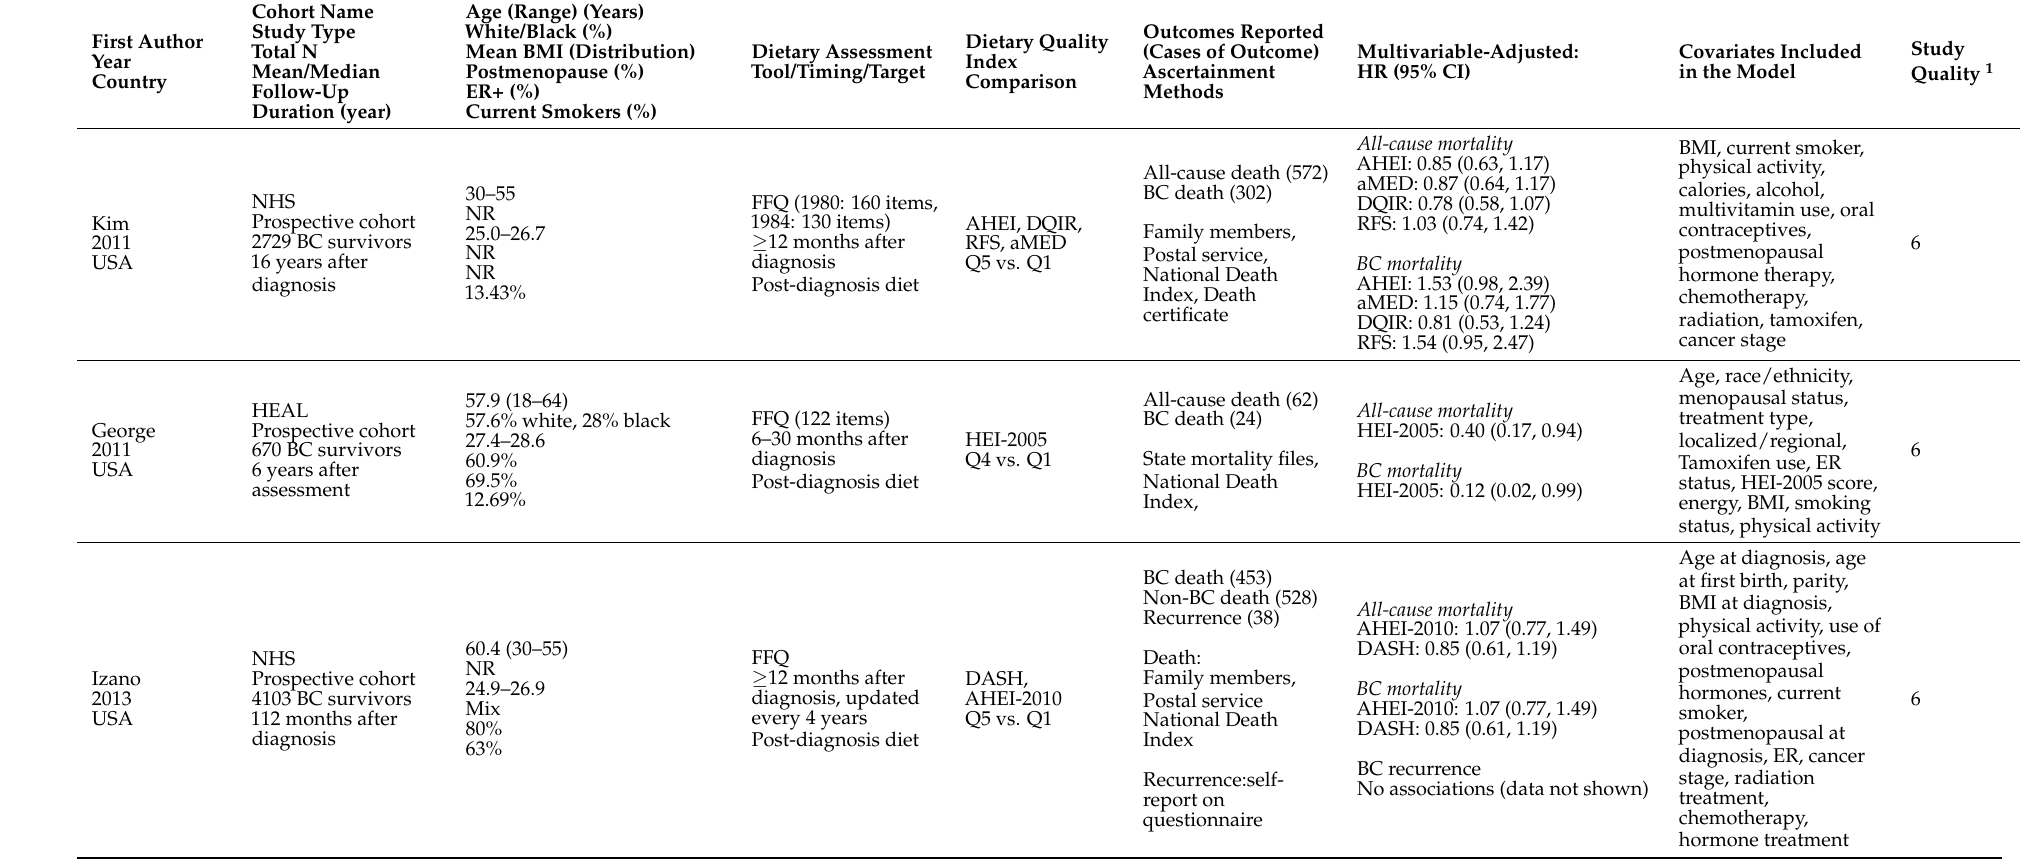
Table 2. Characteristics of included studies ( n =11) examining the association between dietary quality and prognosis in female breast cancer